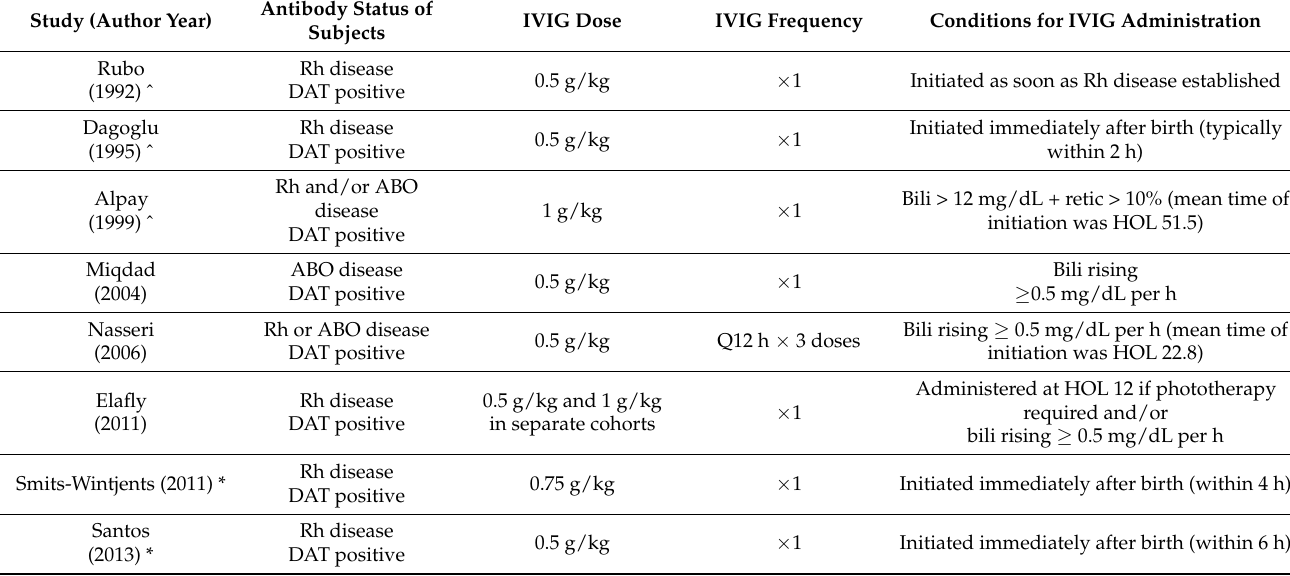
Table 1. Studies used in the 2018 Cochrane Review †